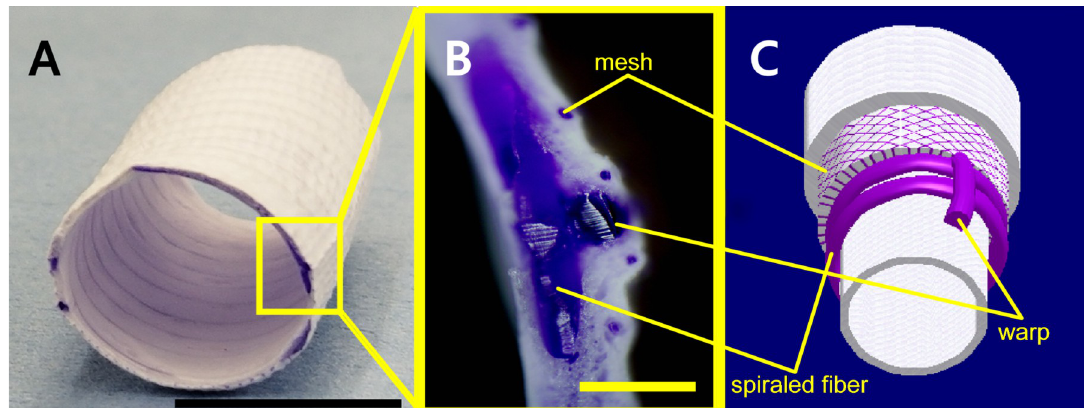
Fig 1. Biodegradable scaffold and iTEV at 1 year post-implantation. (A) Macroscopic images of the biodegradable scaffold used in this study (bar: 1 cm). (B) Higher magnification of a scaffold cross-section (bar: 500 μ m). The spiraled fiber, the longitudinal warp, a cross-section of mesh fibers for scaffold reinforcement, and the honey-comb-shaped sponge are shown. (C) A schematic of the biodegradable scaffold in multiple layers is shown. From the inner side is the sponge composed of L-lactide and ε -caprolactone (PLCL) copolymer, a spiraled 2–0 PLCL fiber, two 2–0 PLCL fiber warps placed in a long-axis direction for reinforcement, a 7–0 meshed PLCL fiber, and the sponge.